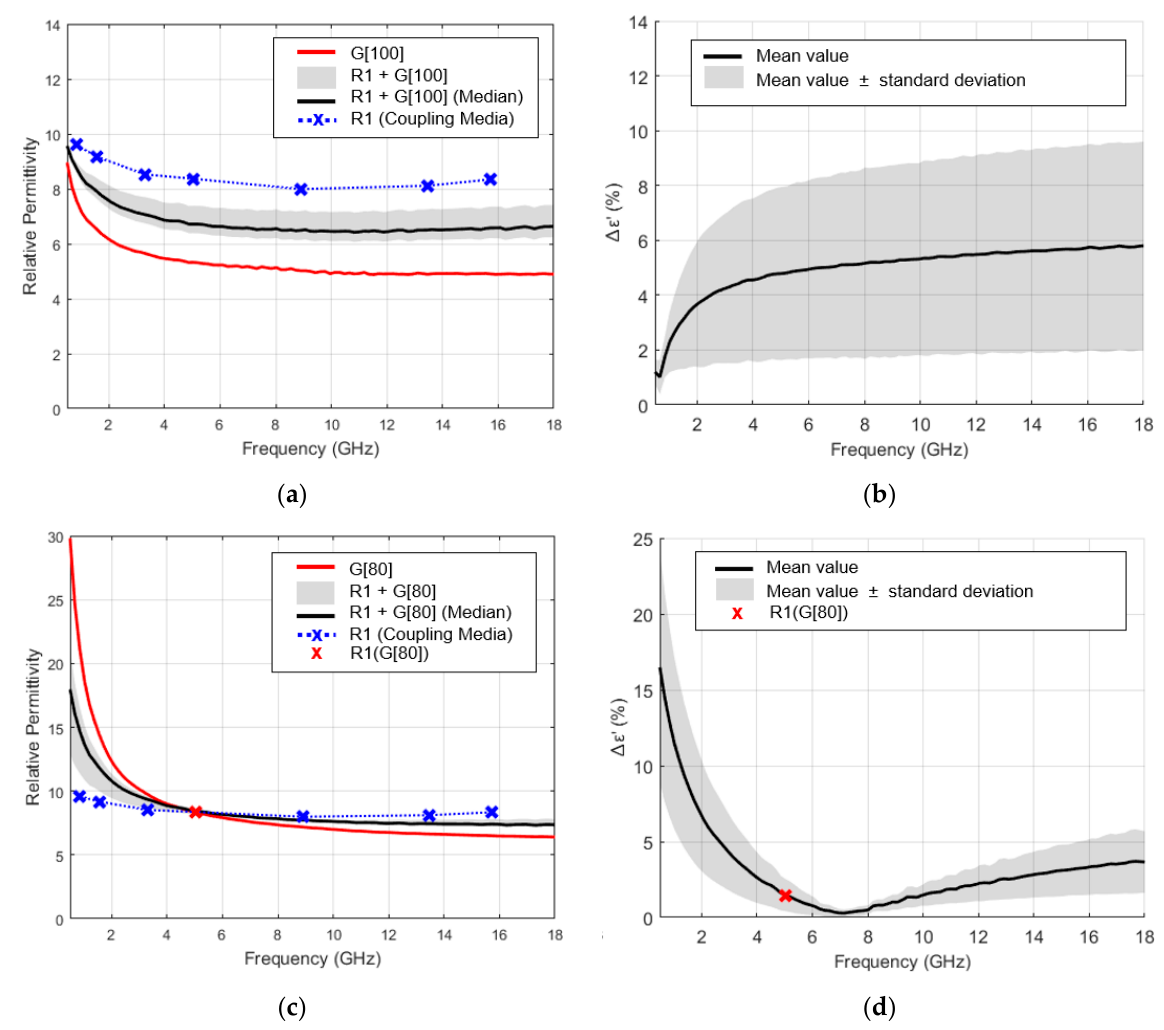
Figure 10. Evaluation of the performance of the method to characterize teeth relative permittivity with the coupling medium. Relative permittivity recorded over molar root (R1 measurement point) with the application of: ( a ) G[100]; ( c ) G[80]. Average percentage variation of the recorded relative permittivity, ∆ε′ (%), with application of: ( b ) G[100]; ( d ) G[80]. Plots ( a ) and ( c ) show the median acquisition represented by the black line over the range of relative permittivity measured with the application of the coupling medium (shaded band). The relative permittivity of the exemplified coupling medium is represented by the red line. The relative permittivity estimated for the tooth, according to the proposed methodology, is represented by crosses over blue dashed line. The relative permittivity estimated with the application of the exemplified coupling medium is marked by a red cross, when it occurs. The average percentage variation of the recorded relative permittivity (black line in ( b ) and ( d ) plots) was taken by the average difference between the relative permittivity recorded for each of the measurements and median measurement. The standard deviation of this variation is shown in the shaded band.